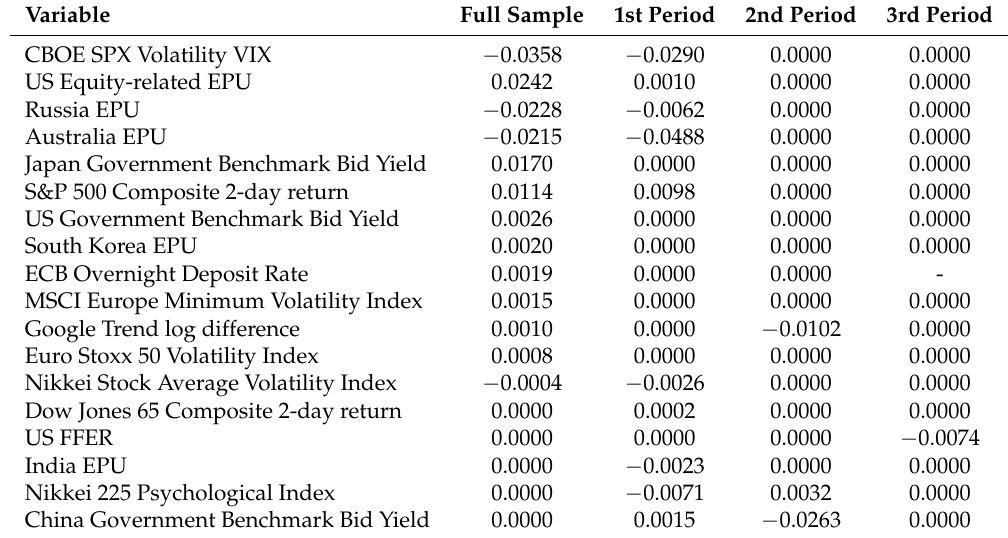
Table 2. PC-LASSO with market/factor type components’ coefficients of independent